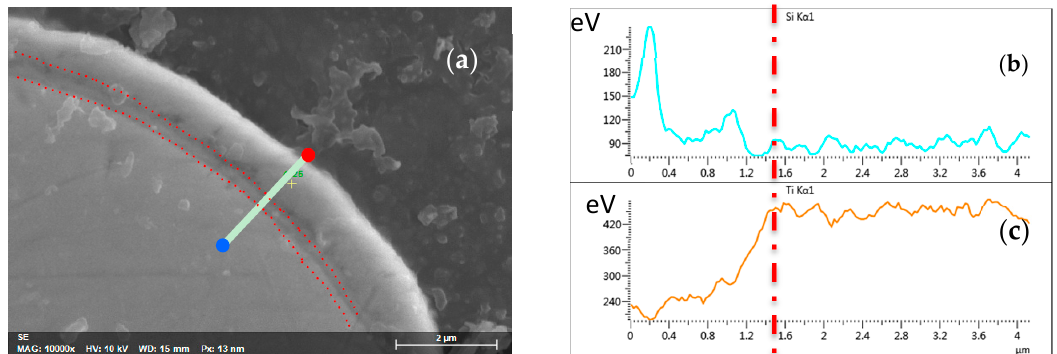
Figure 2. Cross-section morphology ( a ) of MBG-coated Ti-6Al-4V scaffold strut showing an interlayer and the MBG coating layer with a thickness of about 1 μ m and EDS line scan analysis (from the red dot to the blue dot) showing interdiffusion of Si ( b ) and Ti ( c ) across the interlayer between the coating layer and substrate.